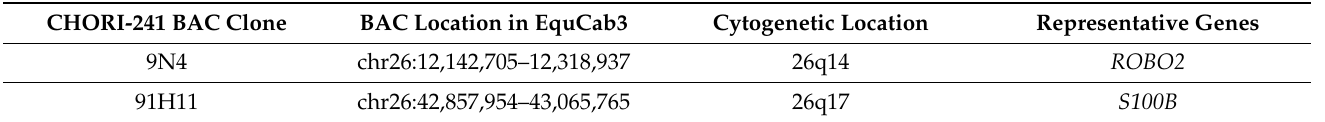
Table 1. Information about ECA26 BAC clones used for FISH. Genomic location of BACs was retrieved from NCBI Genome (https://www.ncbi.nlm.nih.gov/genome/, last accessed 15 October 2021) and cytogenetic map information from [26].